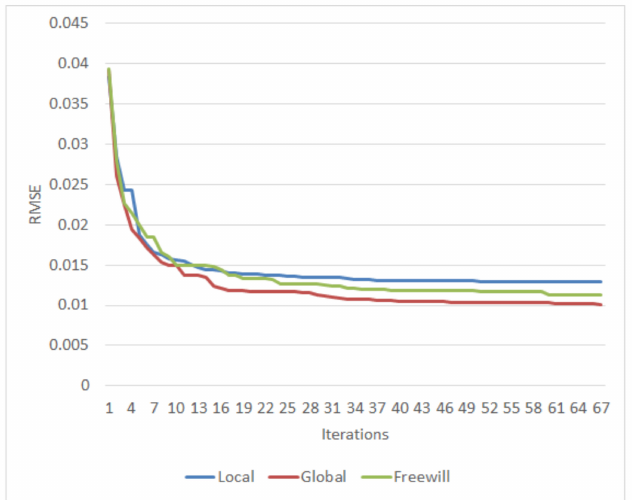
Figure 7. Comparison of convergence using different assimilation strategies: Local assimilation, where countries move toward their imperialist owner; Global assimilation, where a large percentage of the countries move toward the strongest imperialist; Freewill assimilation, where countries move toward an imperialist chosen via roulette-wheel